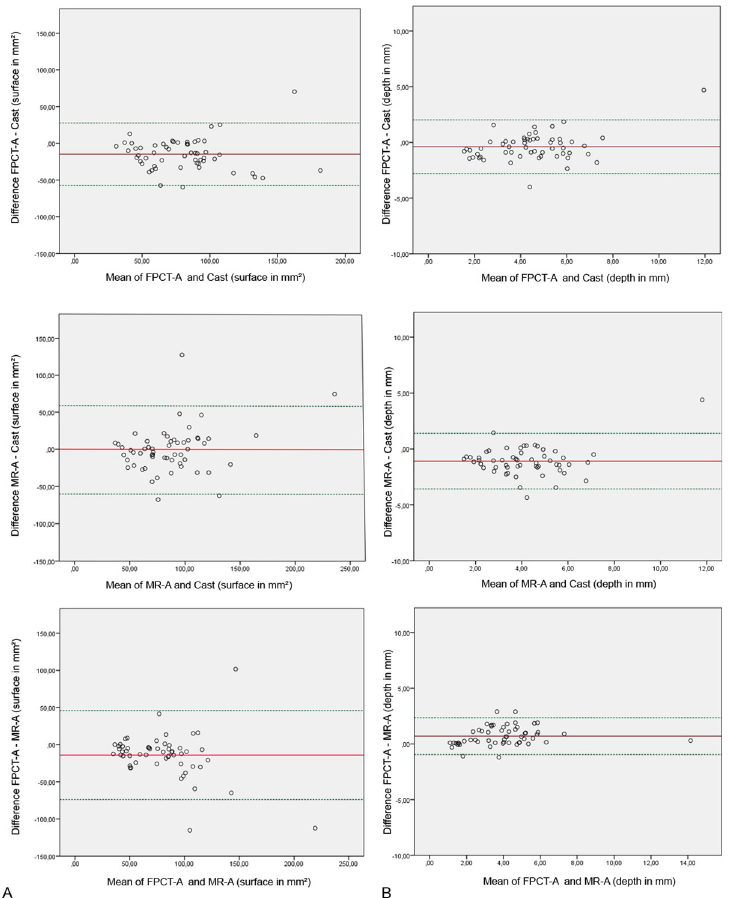
Fig 2. Bland-Altman plots. Bland-Altman plots for flat panel computed tomography arthrography (FPCT-A), magnetic resonance arthrography (MR-A) and cast specimens with mean differences of surface (A) and depth (B) measurements (red line) and ± 1.96 � standard deviation (green dotted lines). The x-axis describes the mean of the data and the y-axis shows the difference of the